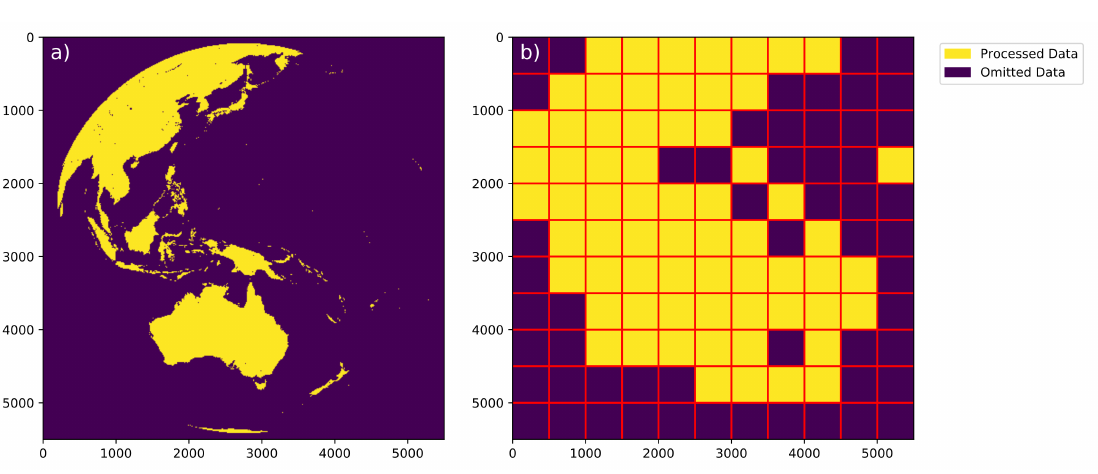
Figure 2. ( a ) land area of the full disk covered by the AHI sensor; ( b ) 500 × 500 image tiles with sufficient land surface processed for the full disk analysis. The horizontal banding of the full disk image in ( b ) also corresponds to the areas selected for the cloud analysis presented in Table